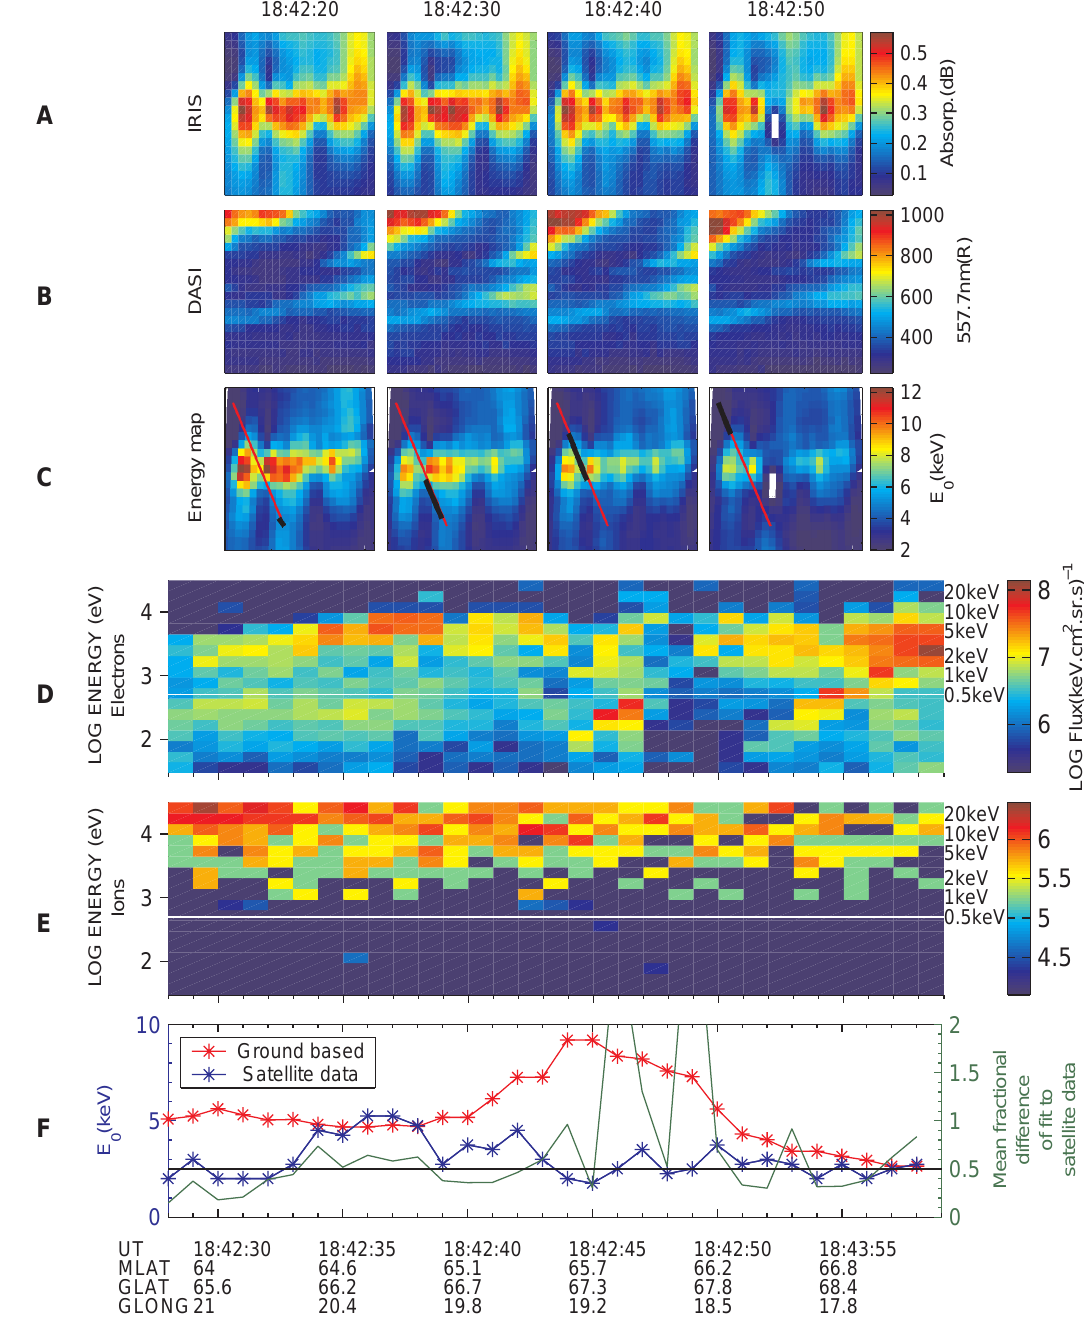
Fig. 4. Panels (A–D) are the same as Fig. 2 but for 1 December 2000, DMSP (F15) and K p =1 − . Panel (E) is the satellite proton energy spectrogram. Panel (F) is the same as panel (E) in Fig.